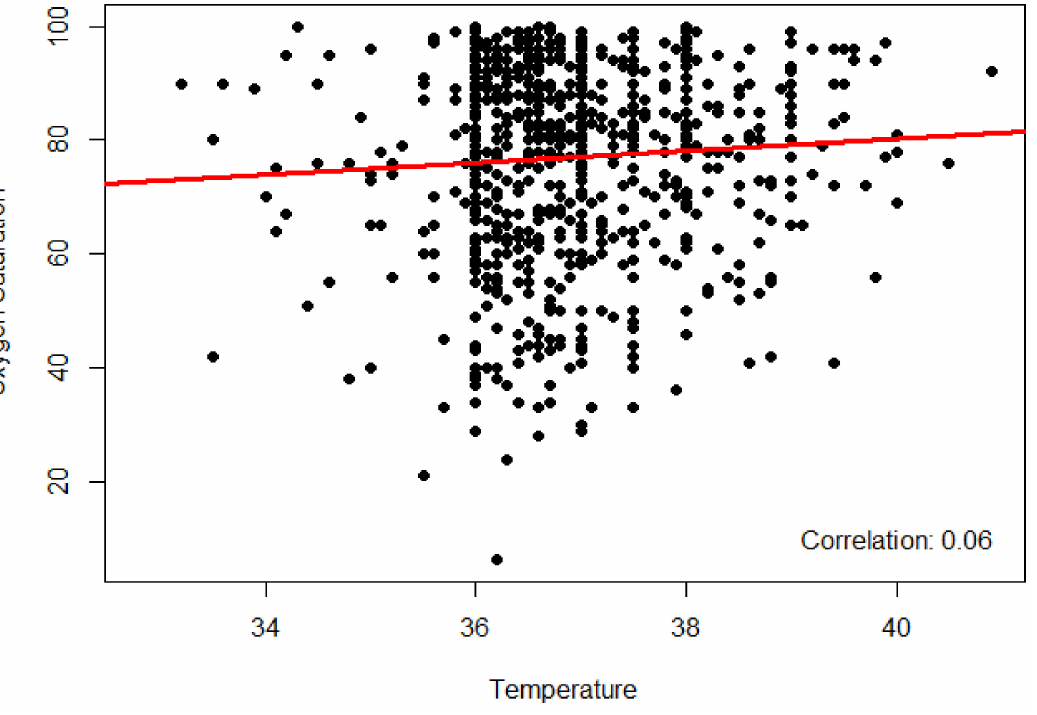
Figure 4. Spearman’s correlation between body temperature and